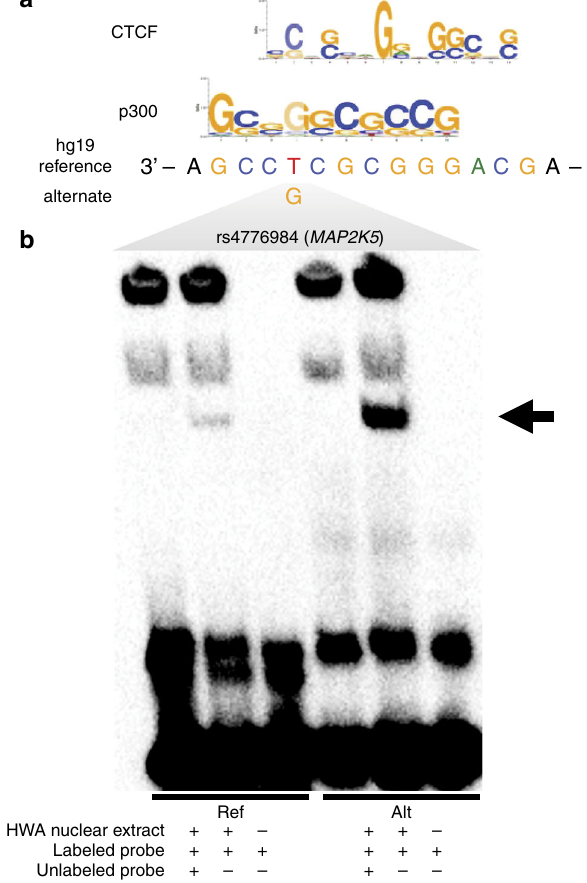
Fig. 4 Predicted TF motifs and electrophoretic mobility shift assay (EMSA) at the rs4776984 site indicate allele-speci fi c binding. a Predicted TF motifs for CTCF and p300, as well as the hg19 reference genome sequence. b Biotinylated (labeled probe) 31-bp oligonucleotide complexes with ±15 bp fl anking the reference or alternate allele for variant rs4776984 were incubated with nuclear protein extracted from primary HWA and resolved on a 6% polyacrylamide gel. Competitor assays were performed by incubating the reaction with ×100 excess of unlabeled (no biotin) oligonucleotide complexes with identical sequence. Arrow denotes speci fi c binding of HWA nuclear protein to reference (left) and alternate